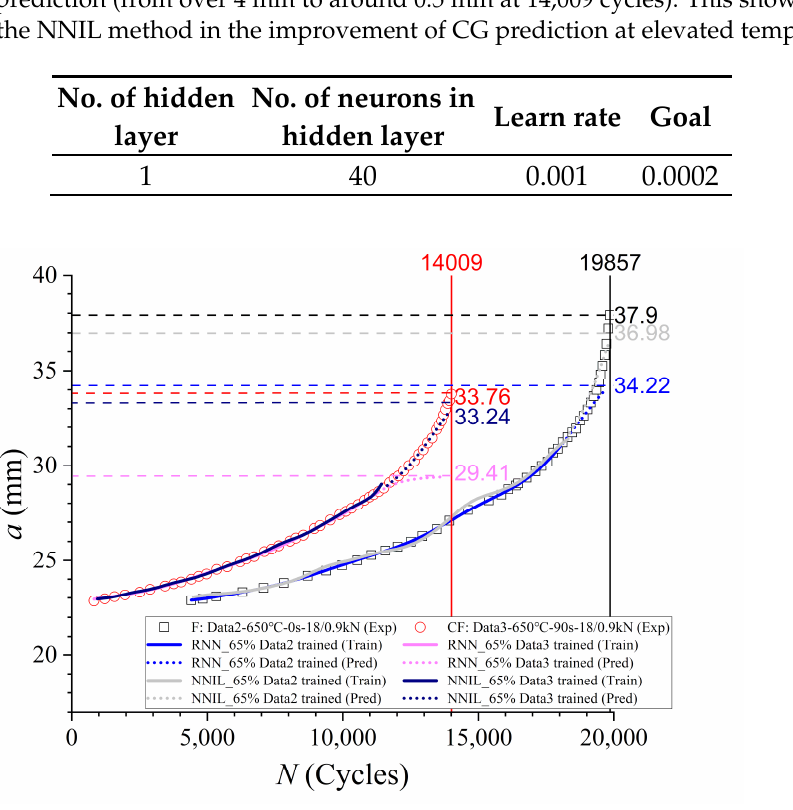
Figure 10. Prediction of a-N curves using basic scheme (RNN) for ( a ) Data2 and Data3, respectively; ( b ) Data2 with various of trained data percentage.